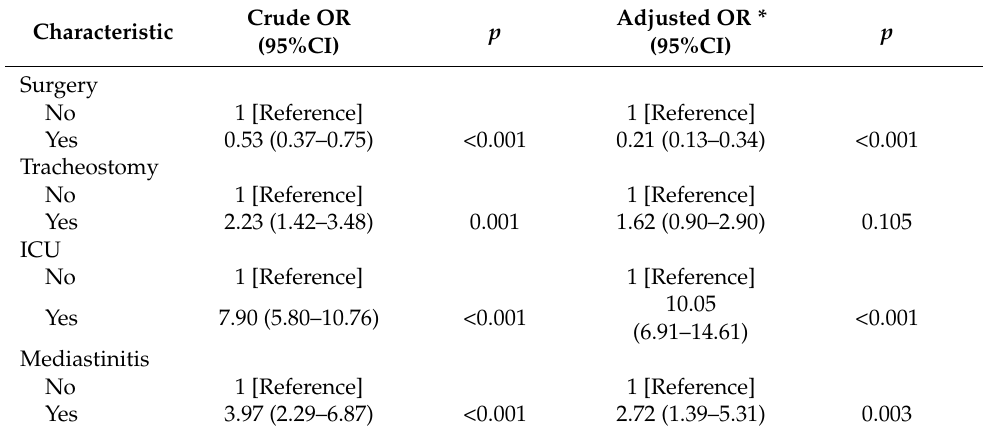
Table 3. Odd ratios of mortality for various variables in DNI patients.